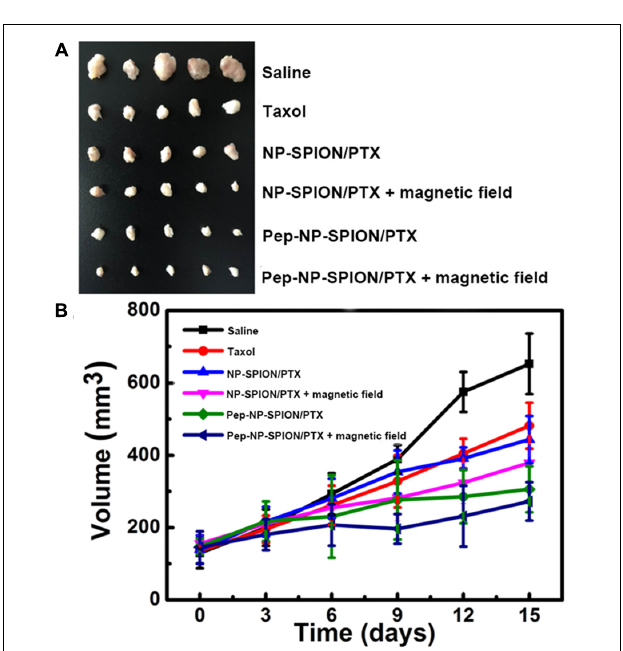
FIGURE 8 | Anti-tumor efficacy of Taxol R (cid:13) , NP-SPION/PTX and Pep-NP-SPION/PTX on tumor xenograft mice. Tumor xenografts alignment of each group taken out from the sacrificed mice at the end point (A) and tumor growth volume vs. time (B) . ( n = 5).